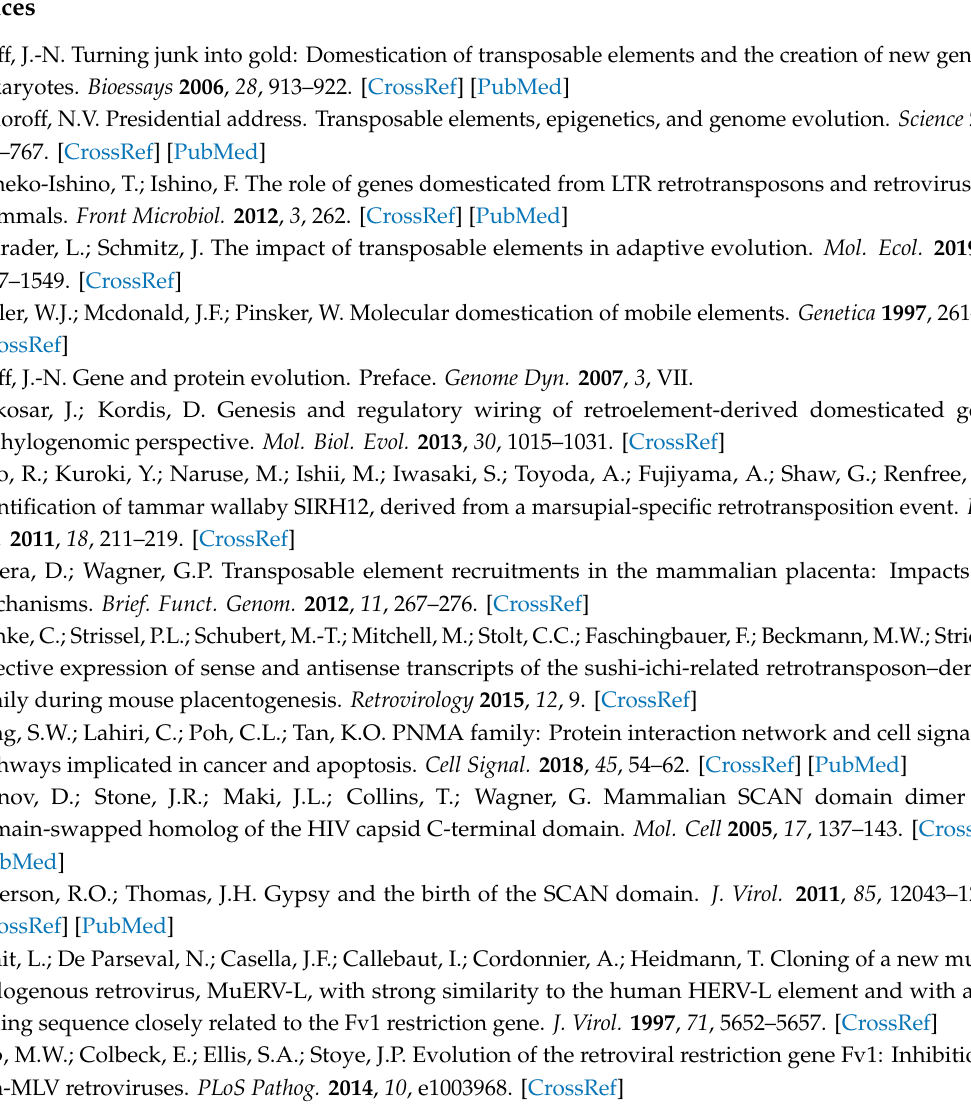
Table S1: Nodes and edges of co-expression networks. Table S2: Weight matrices found in the study of promoters co-expressed with Gagr genes. File S1: Multiple alignment: Alignment of the promoter regions of the Gagr gene and its